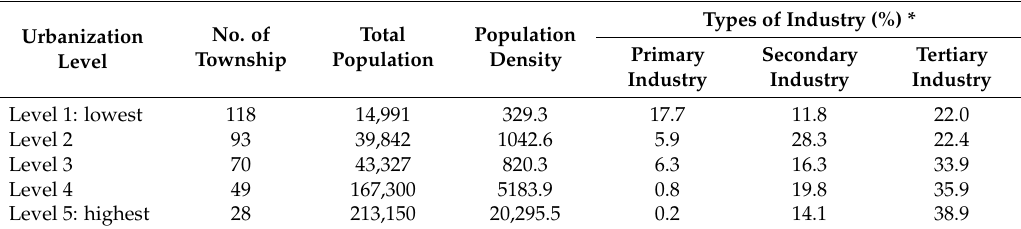
Table 2. Urbanization level of 358 townships using cluster analysis.